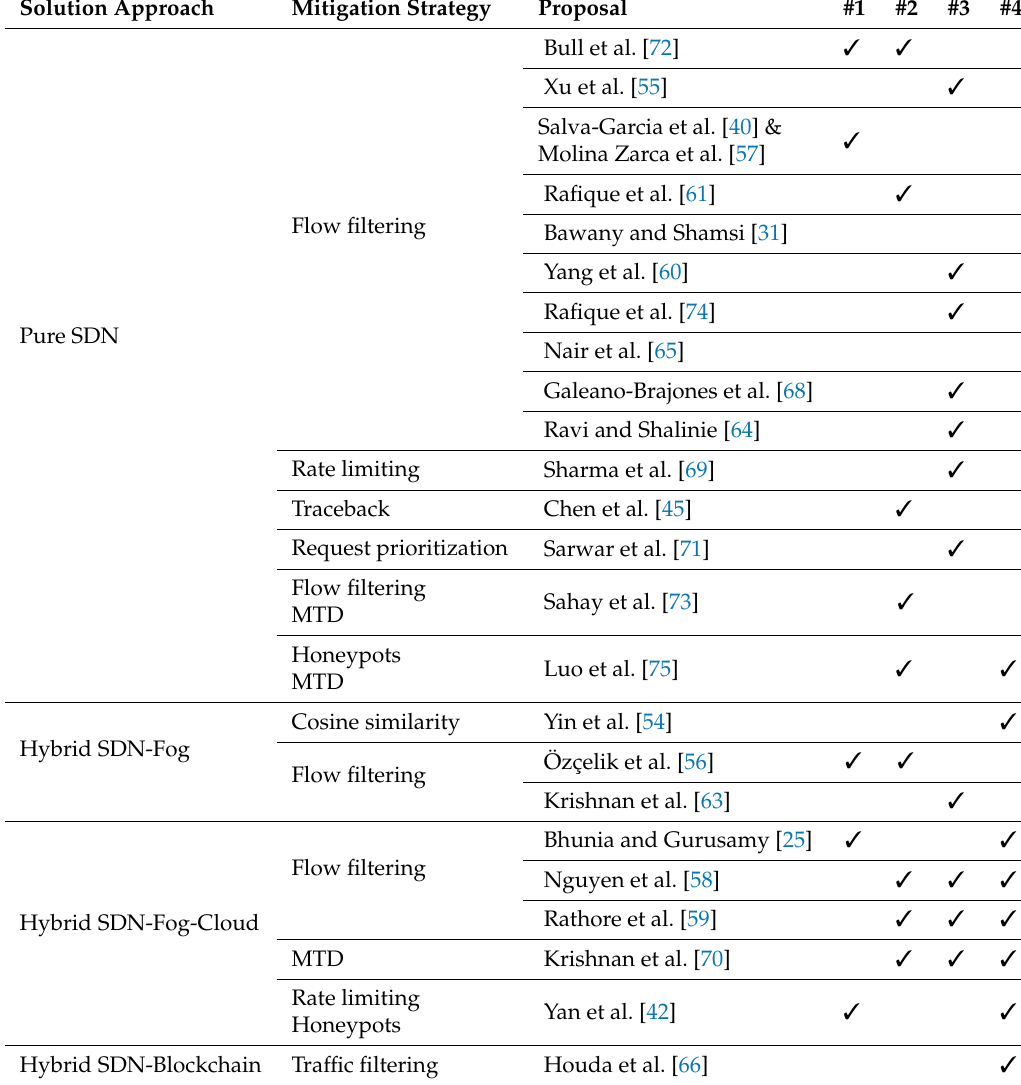
Table 3. Comparison of mitigation solutions using Software-Defined Networking (SDN) in IoT environments. Solution